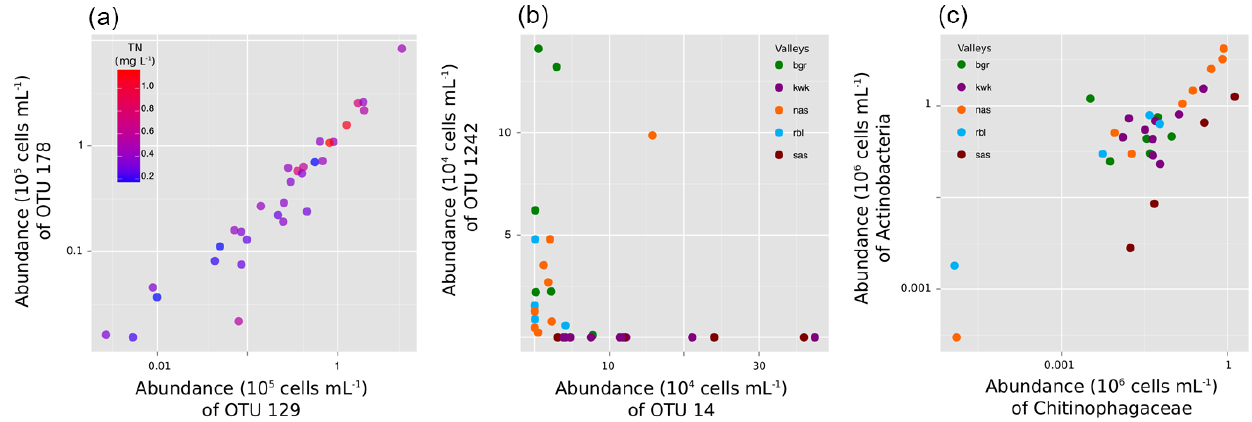
Figure 5. Associations between bacterial OTUs in permafrost thaw ponds and lakes. (a) Co-occurrence between two representatives of Gammaproteobacteria that is partially explained by total nitrogen. (b) Non-coexistence that is explained by the valley identity. (c) Co- occurrence between OTUs closely related to Actinobacteria ACK-M1 and Bacteroidetes Chitinophagaceae